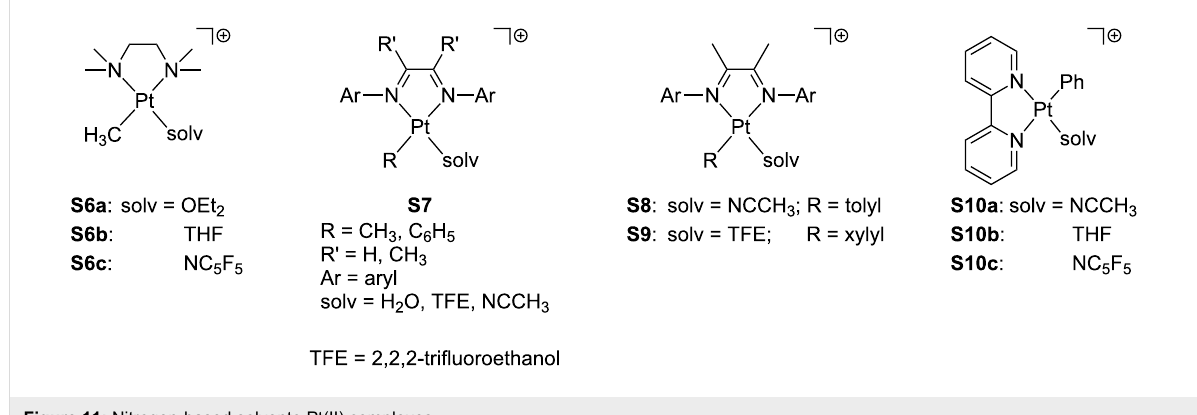
Figure 11: Nitrogen-based solvento Pt(II)